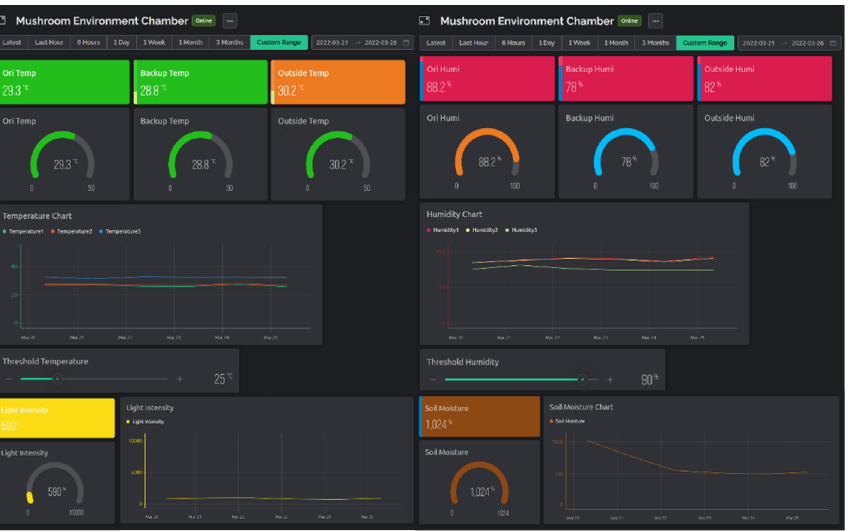
Figure 6. The user interface of the web dashboard presenting the real time status of different conditions in the mushroom cultivation chamber.